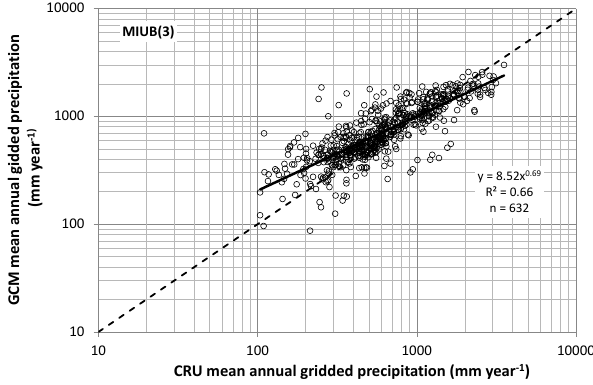
Figure 1. Comparison of MIUB(3) model estimates of observed mean annual precipitation with CRU estimates. (Based on untrans- formed precipitation NSE = 0.678, rank 1 of 46 runs, and R 2 = 0 . 691.)